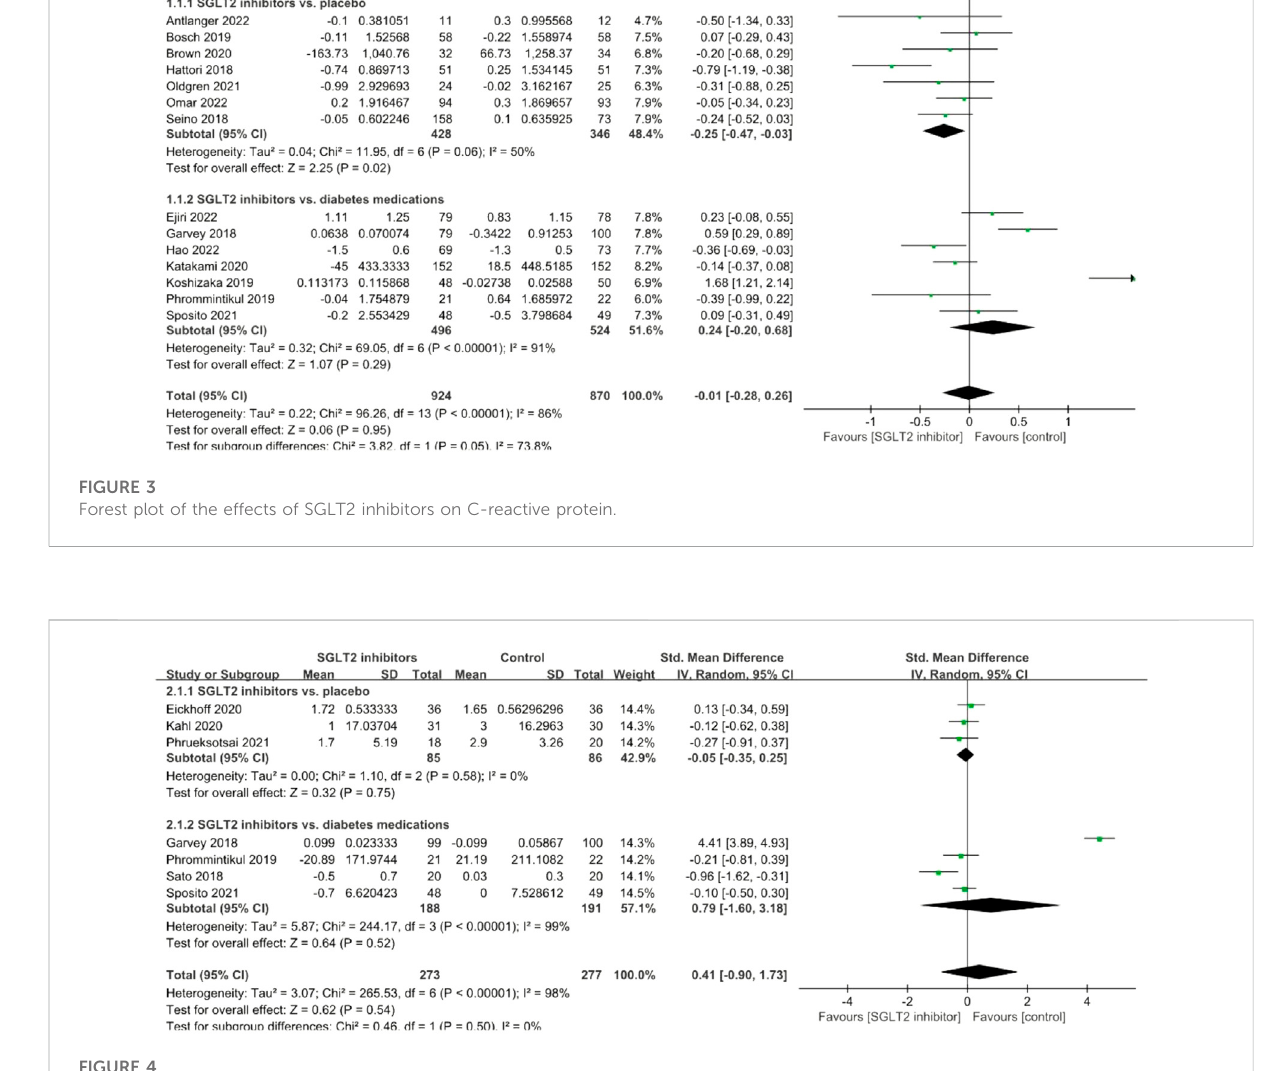
Forest plot of the effects of SGLT2 inhibitors on tumor necrosis